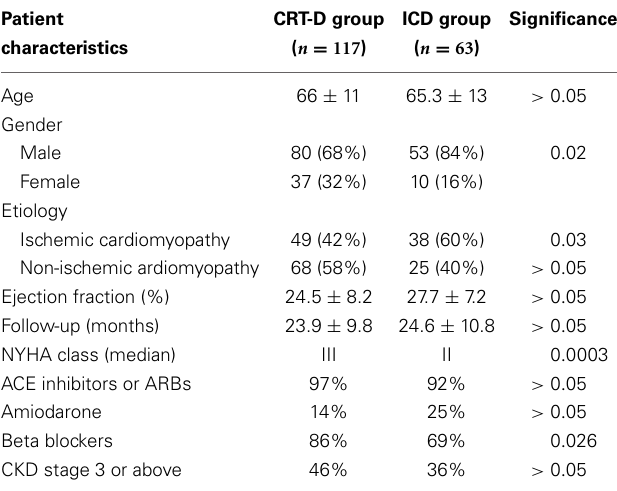
Table 1 | Patient characteristics of both groups (ACE, Angiotension Converting Enzyme; ARB, Angiotensin Receptor Blockers; CKD, Chronic Kidney Disease; NYHA, New York Heart Association).